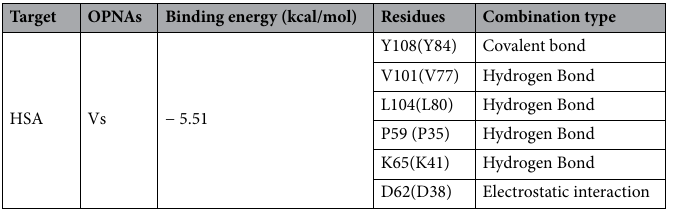
Table 11. The promoting factors for the formation of adduct between Vs and Y108. Residue number is from Uniprot website, number in brackets is from PDB, with a difference of